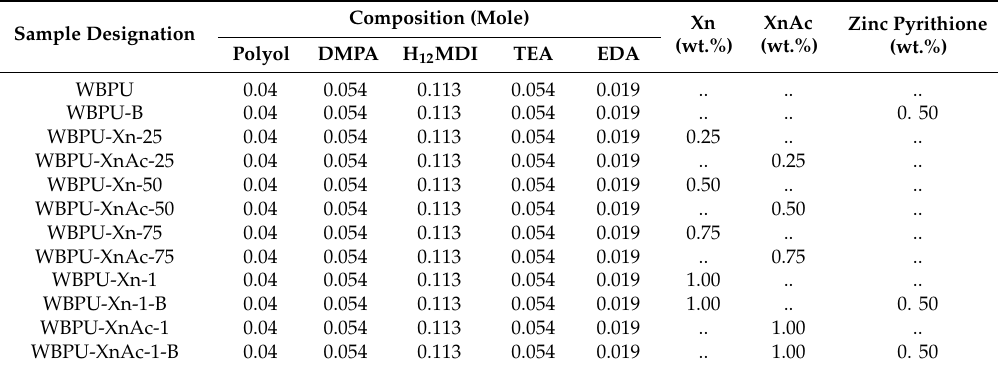
Table 1. Sample designation and composition of